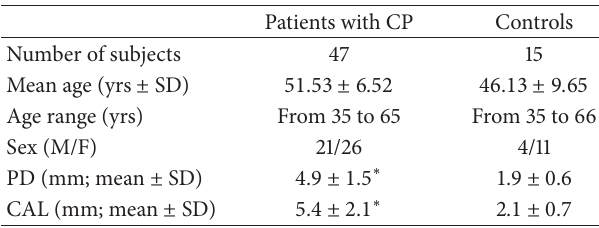
Table 1: Demographic and clinical data in patients with chronic periodontitis (CP) and nonperiodontitis